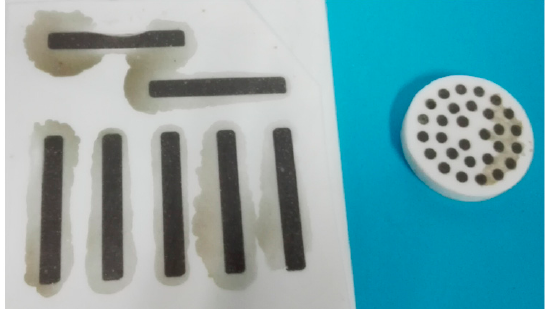
Figure 2. Molds with bending and compression specimens.